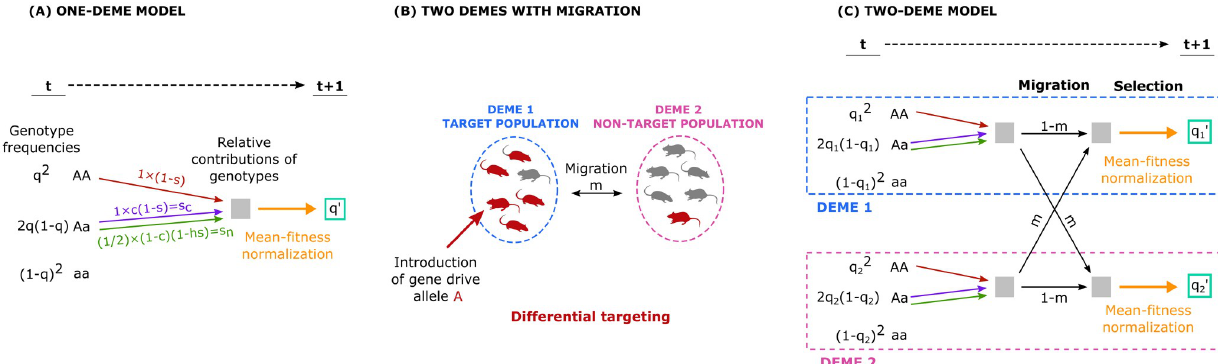
Fig 1. Schematic depiction of gene-drive models. (A) Model of CRISPR-based gene drive in an isolated population (Eq 1). Shown is the change of the allele frequency of the gene-drive allele A over one generation, from t to t + 1. Each genotype contributes to the frequency of A in generation t + 1 depending on its frequency in generation t and the genotype fitnesses: the AA genotype contributes an A allele (red arrows), and the heterozygous genotype Aa contributes 1 (purple arrow) or 1/2 allelic copies (green arrow), depending on whether gene drive conversion occurs (at rate c ). (B) A two-deme configuration with migration. The gene drive is introduced to the target population, and it can spread to the non-target population through migration. Differential targeting, when possible, would produce convergence to a stable state in which gene-drive frequencies are high in deme 1 and low in deme 2. (C) A two-deme model of gene-drive dynamics in which migration occurs before selection. Black arrows denote migration (Eq 2). The colored arrows (red, green, and purple) represent the contributions of the different genotypes to the next generation’s pre-migration gene pool. q 0 the relative contributions to the frequency of A by the mean fitness of the post-migration population (Eq